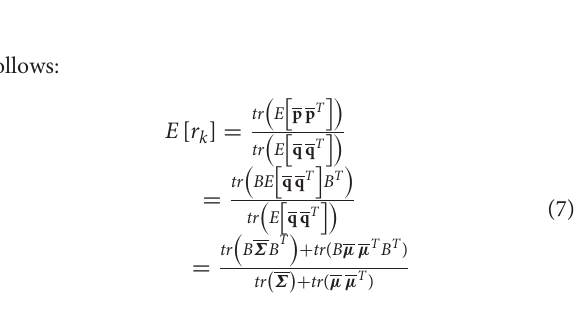
FIGURE 1 | Model components and behavior. The user is composed of a generative model (1) that describes the probability of drawing a certain n-dimensional action q k at the instant k . The action q k contributes to generating a smooth trajectory of control signals s k for the interface (2). The interface map computes a vector p k of a dimension m < n and provides it to the user as feedback related to the smooth control action s k (3). The user model processes the feedback assigning a reward for the action based on the feedback (4). After each iteration, the map recursively updates its parameters based on the distribution of the observed user commands s k with learning rate γ . The user updates its generative model with learning rate η after a feedback is received, reinforcing the generated smooth action according to its